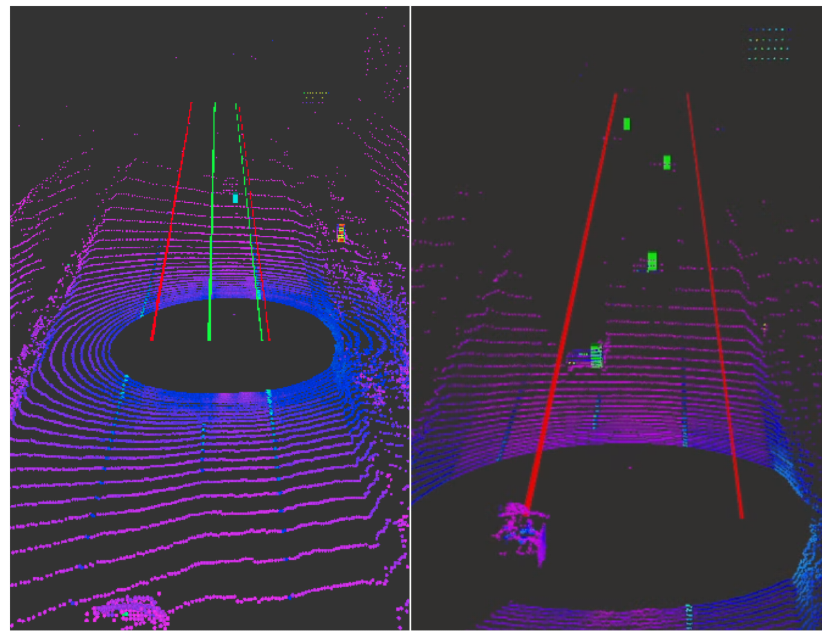
Figure 13. Higher accuracy and low computational power for MobilEye/Aptiv ESR sensor fusion using a Dynamic Region of Interest (DROI) [72]. Current sensor fusion algorithm to reduce radar detections, which can be seen as the blue marker for the ( left ) and green markers for the ( right ).